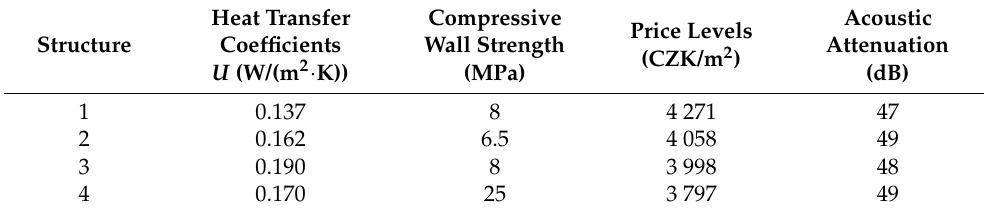
Table 3. Technical parameters of external walls.